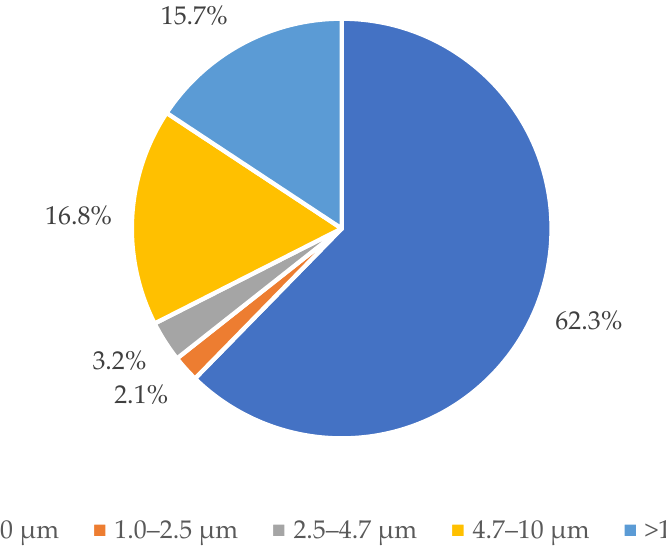
Figure 4. Size distribution of poultry dust particles.